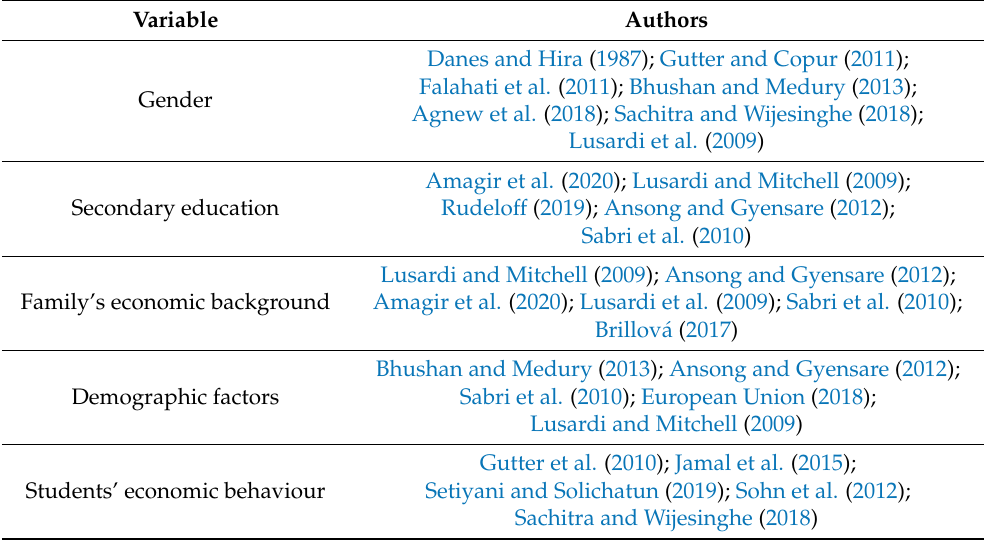
Table 1. List of variables studied in previous